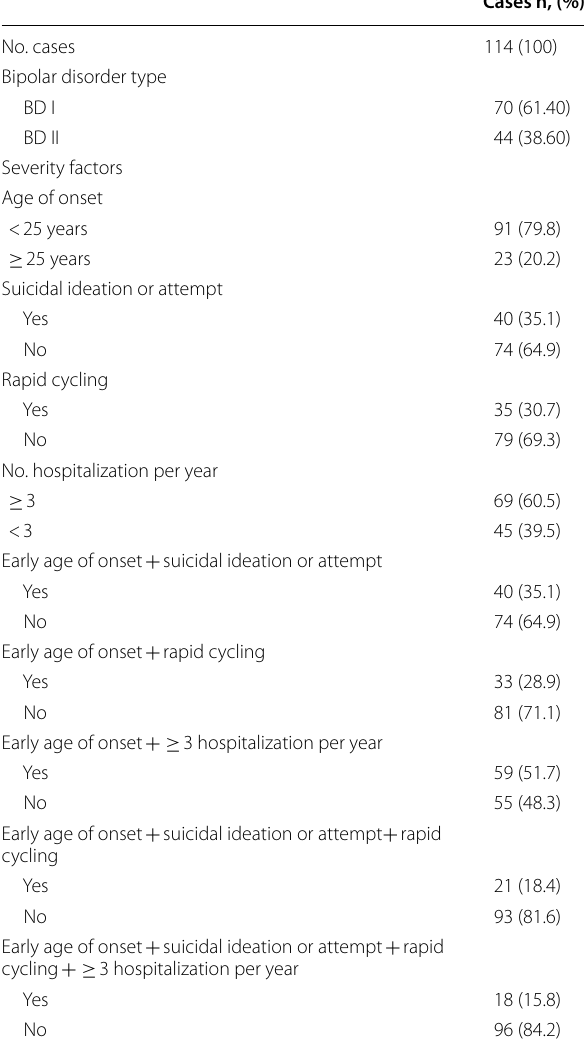
Table 2 Severity factors in bipolar patients (N